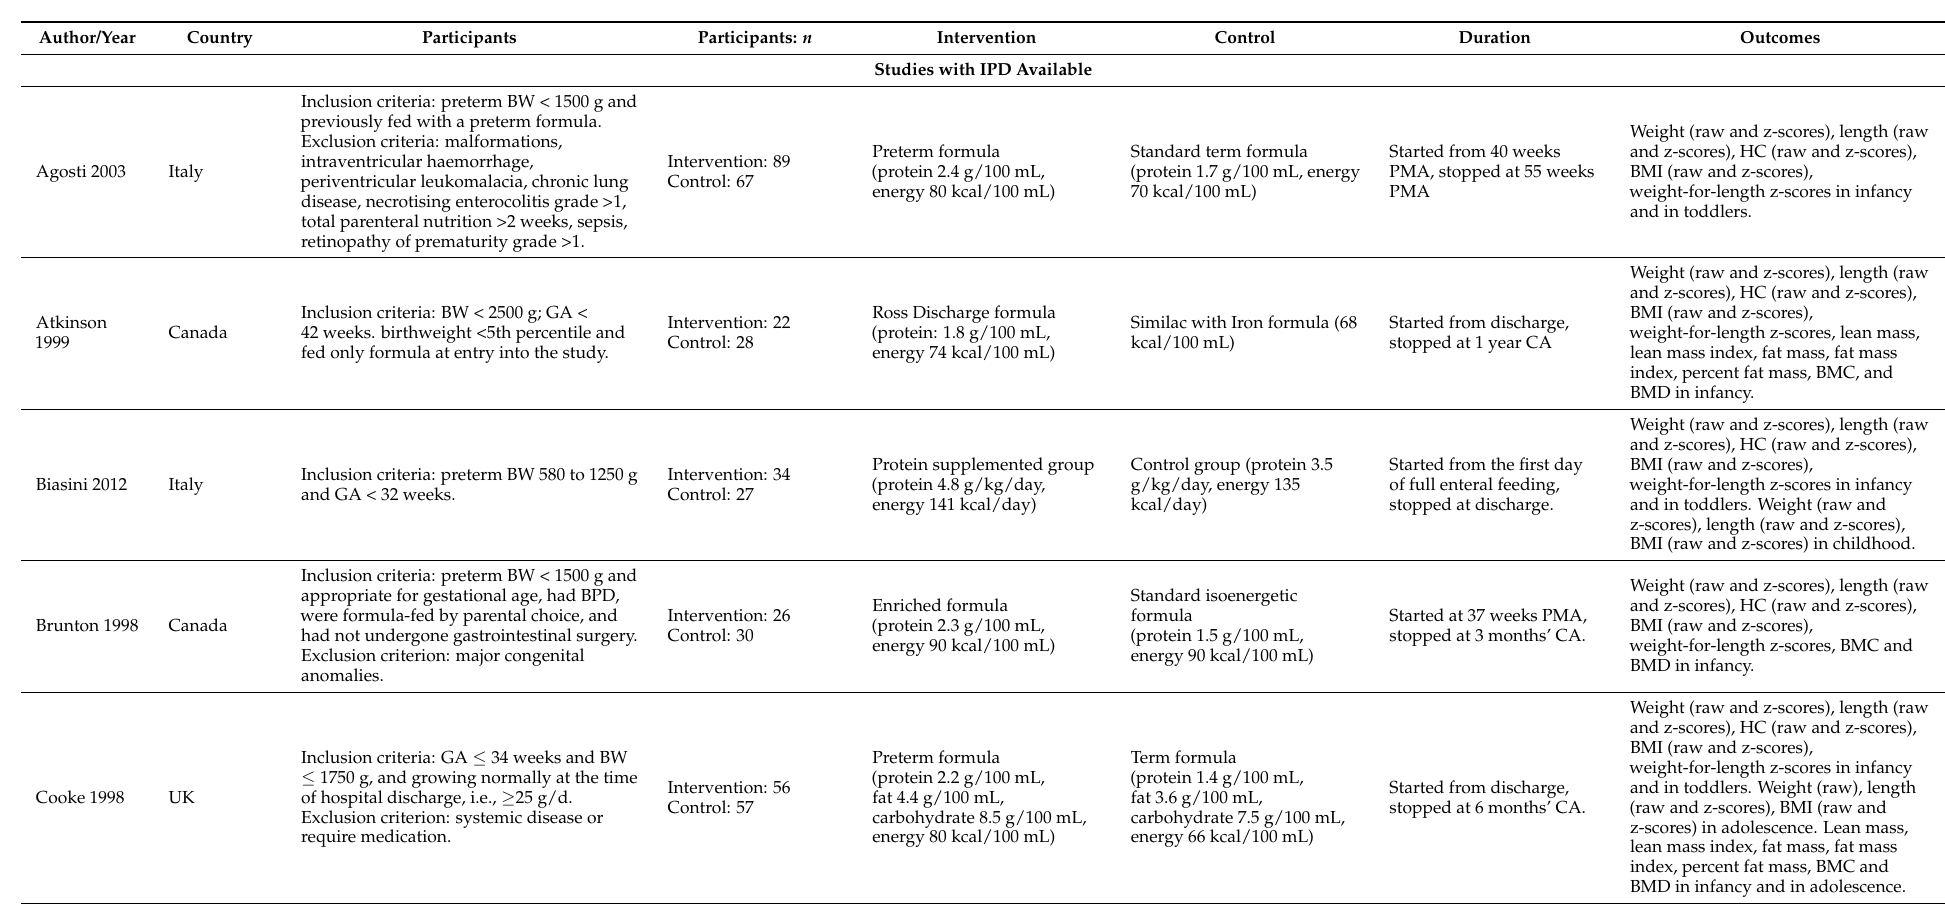
Table 1. Included trials and their